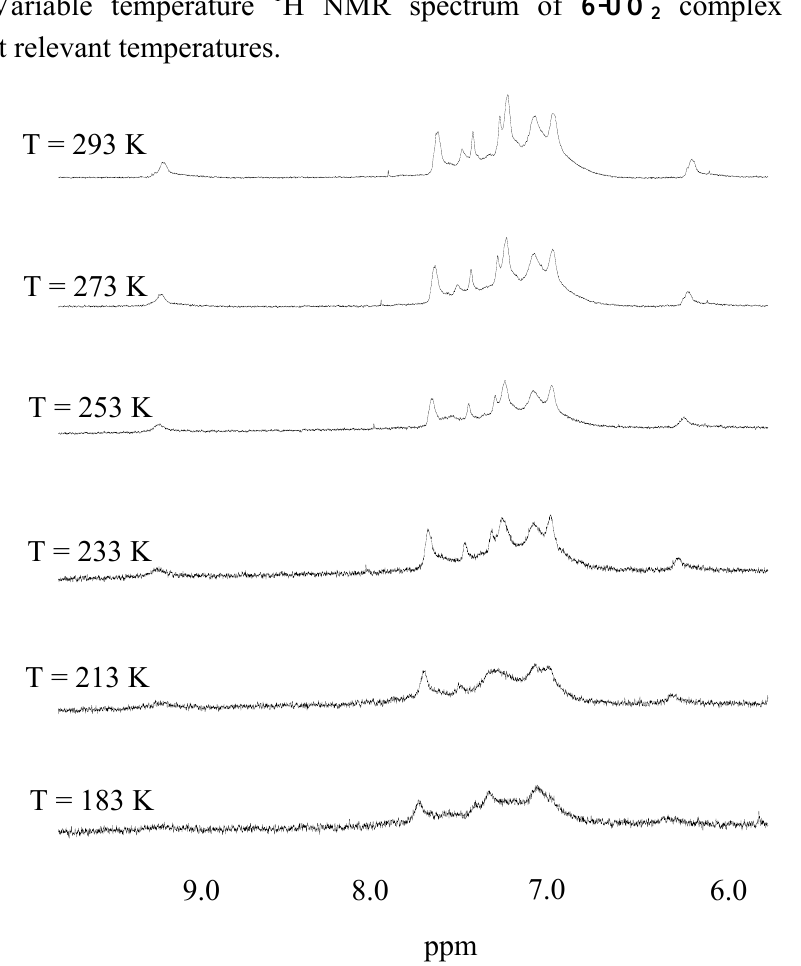
complex (500 MHz, 2